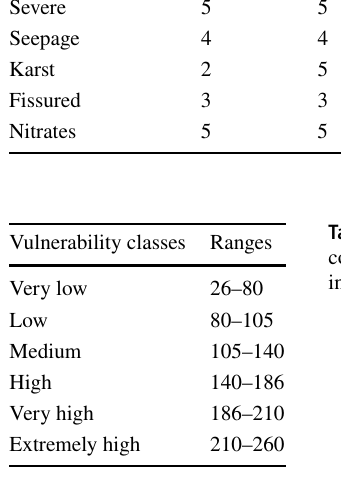
SINTACS method (Civita and De Maio 1997)